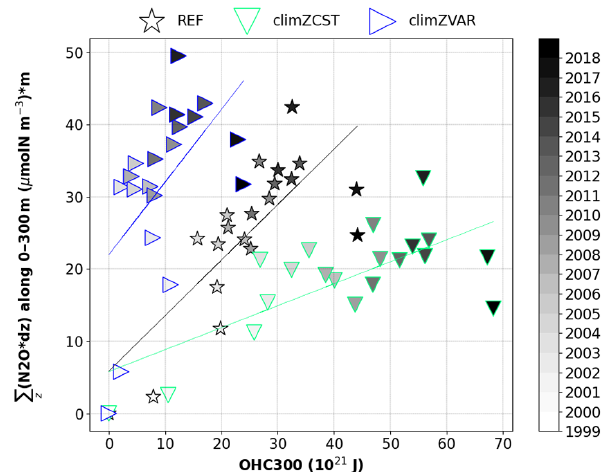
Figure 6. Annual N 2 O inventory vertically integrated over the first 300m depth (µmolNm − 2 ) as a function of the annual OHC300 (ZJ) and averaged over an extended tropical domain (35 ◦ S–35 ◦ N). All points reflect anomalies compared to year